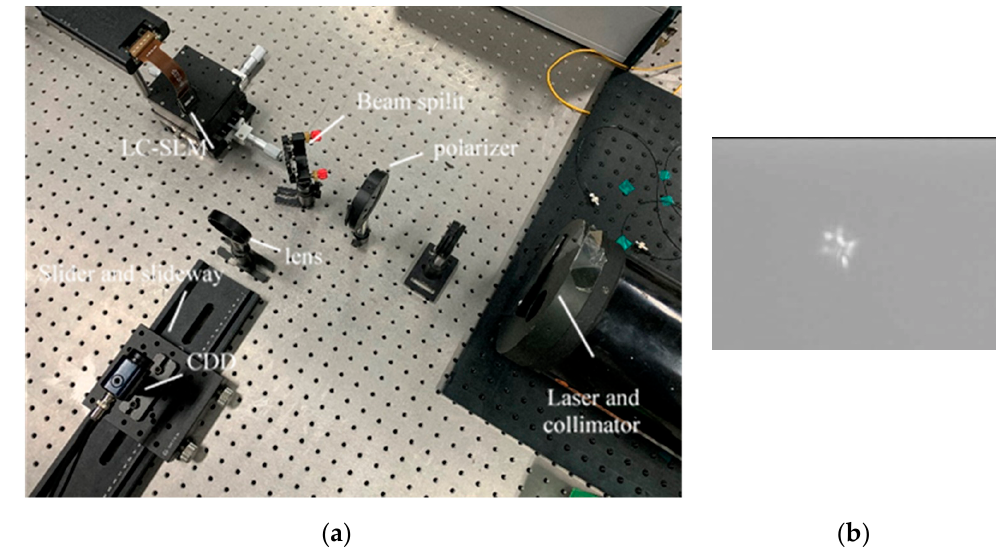
Figure 4. ( a ) The system used in the experiment and ( b ) the PSF of the defocused plane.